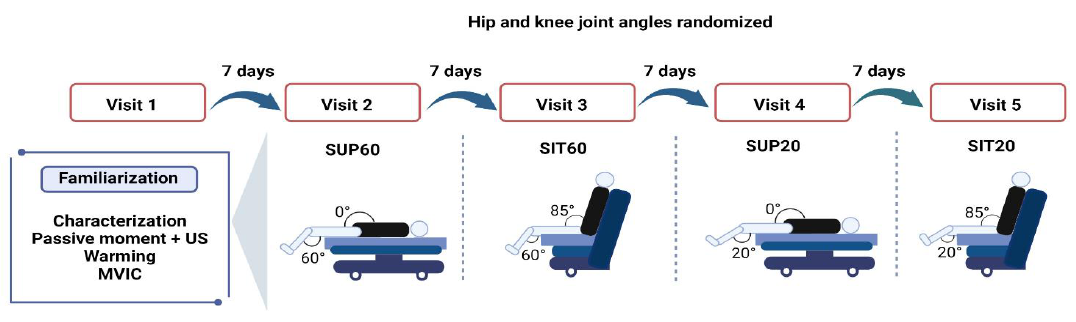
Figure 1. Design of the experimental conditions: participants engaged in five designed sessions at least seven days apart, a familiarization and four experimental sessions to randomly test four compositions of hip and knee joint angles during quadriceps femoris musculature (QF). Twelve MVICs were required at each visit. Legend: MVIC: Maximal Voluntary Isometric Contraction; SUP60: su- pine with 60° of knee flexion; SIT60: seated with 60° of knee flexion; SUP20: supine with 20° of knee flexion; SIT20: seated with 20° of knee flexion.